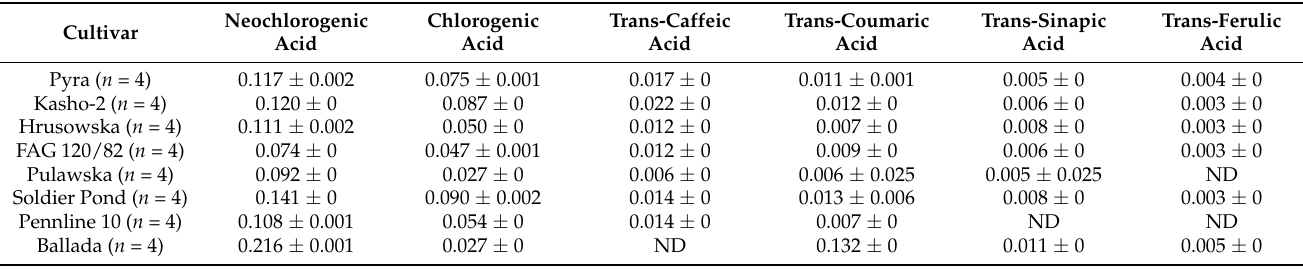
Table 5. Content of phenolic acids in grain of investigated buckwheat cultivars (mg/g d.w., means ± standard deviations of four independent